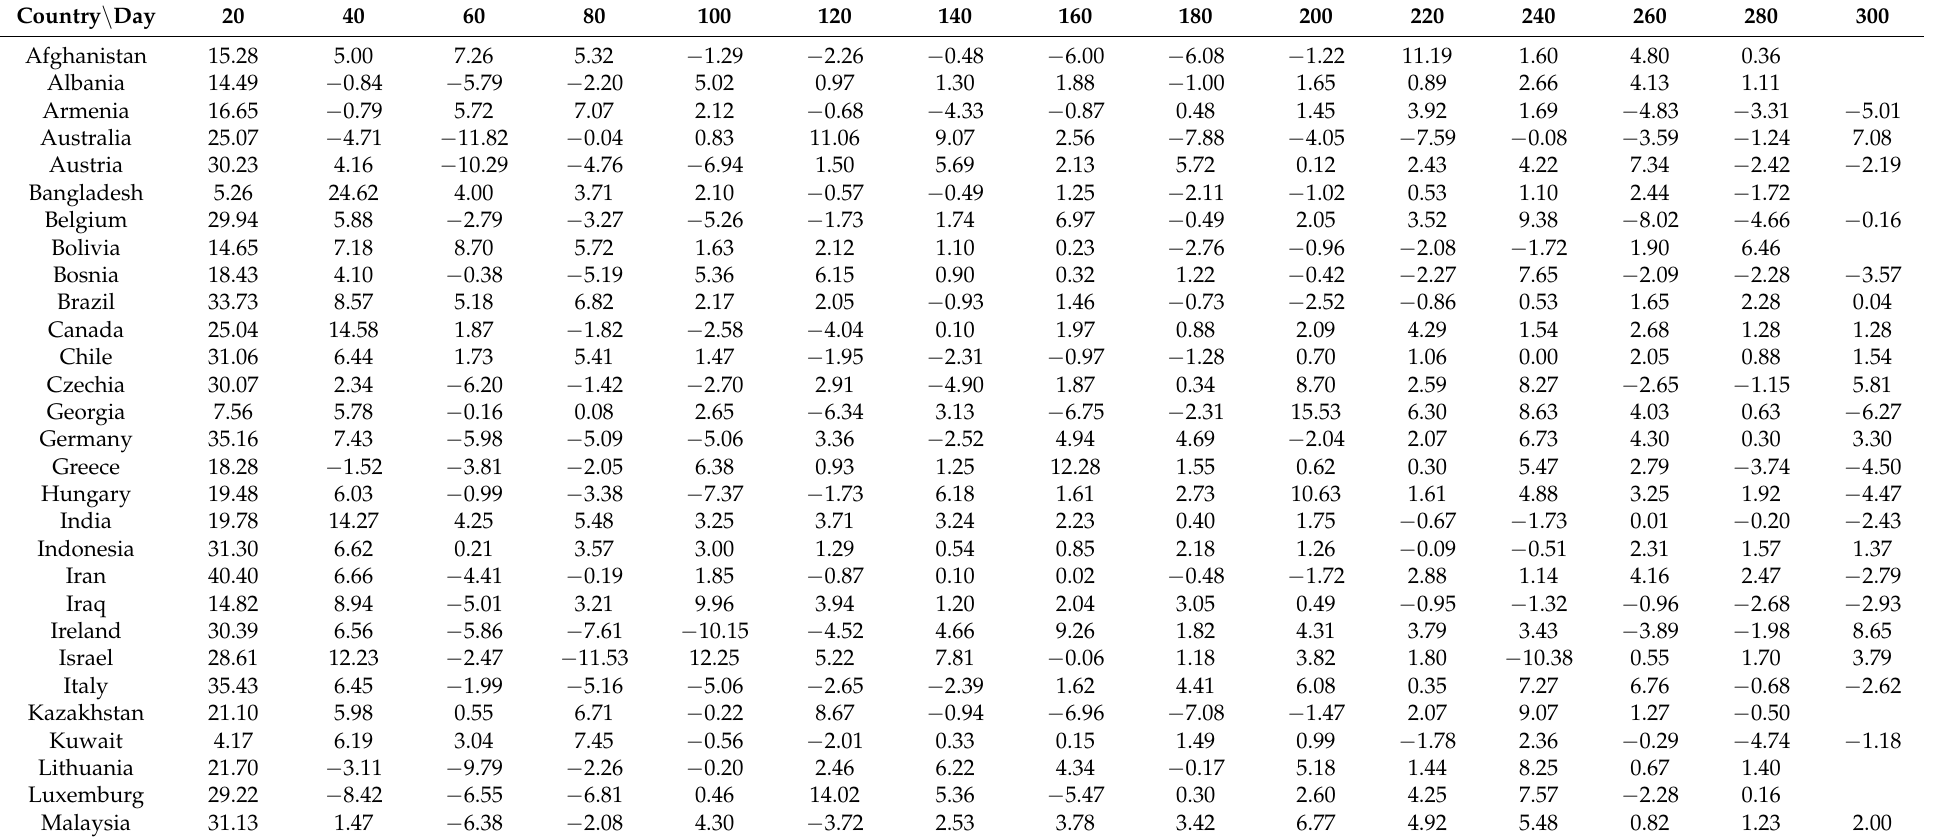
Table 4. Spread rates ( × 100) for COVID-19 in the 51 countries for 15 consecutive nonoverlapping 20-day time periods. N > 0, numbers of positive rates, Mean is mean rates. Days are since pandemic onset in that state, which differs among states. P K-S are p values along the Kolmogorov–Smirnov test for normality. Country \